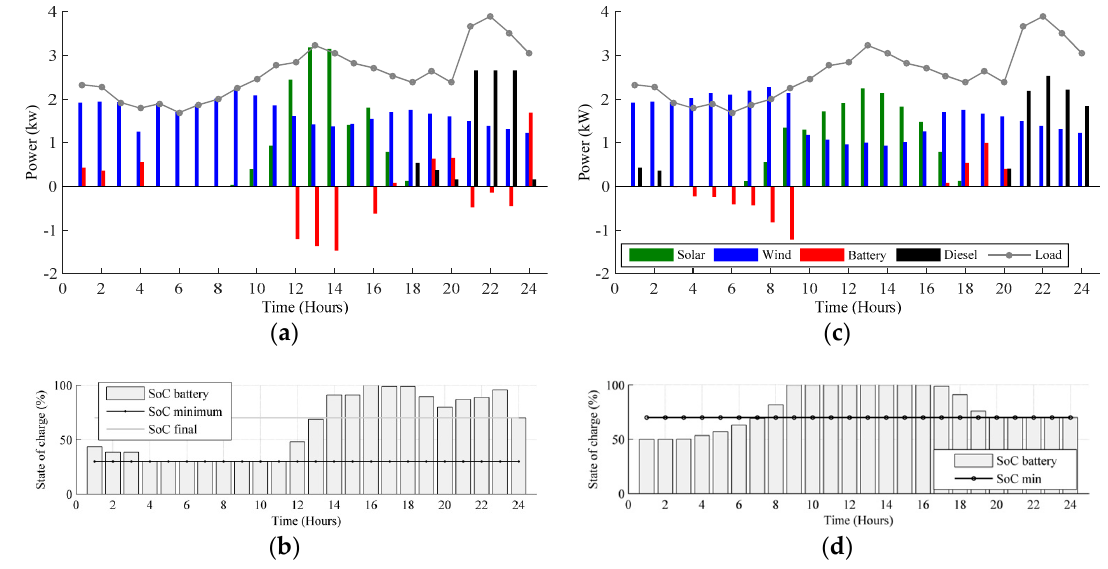
Figure 7. ( a ) Power dispatch using the Mixed integer linear programming (MILP) approach; ( b ) State of charge (SoC) of the battery bank using the MILP approach; ( c ) Power dispatch using the heuristic algorithm; ( d ) SoC of the battery bank using the heuristic algorithm. Table 2. Operating costs comparison per day.